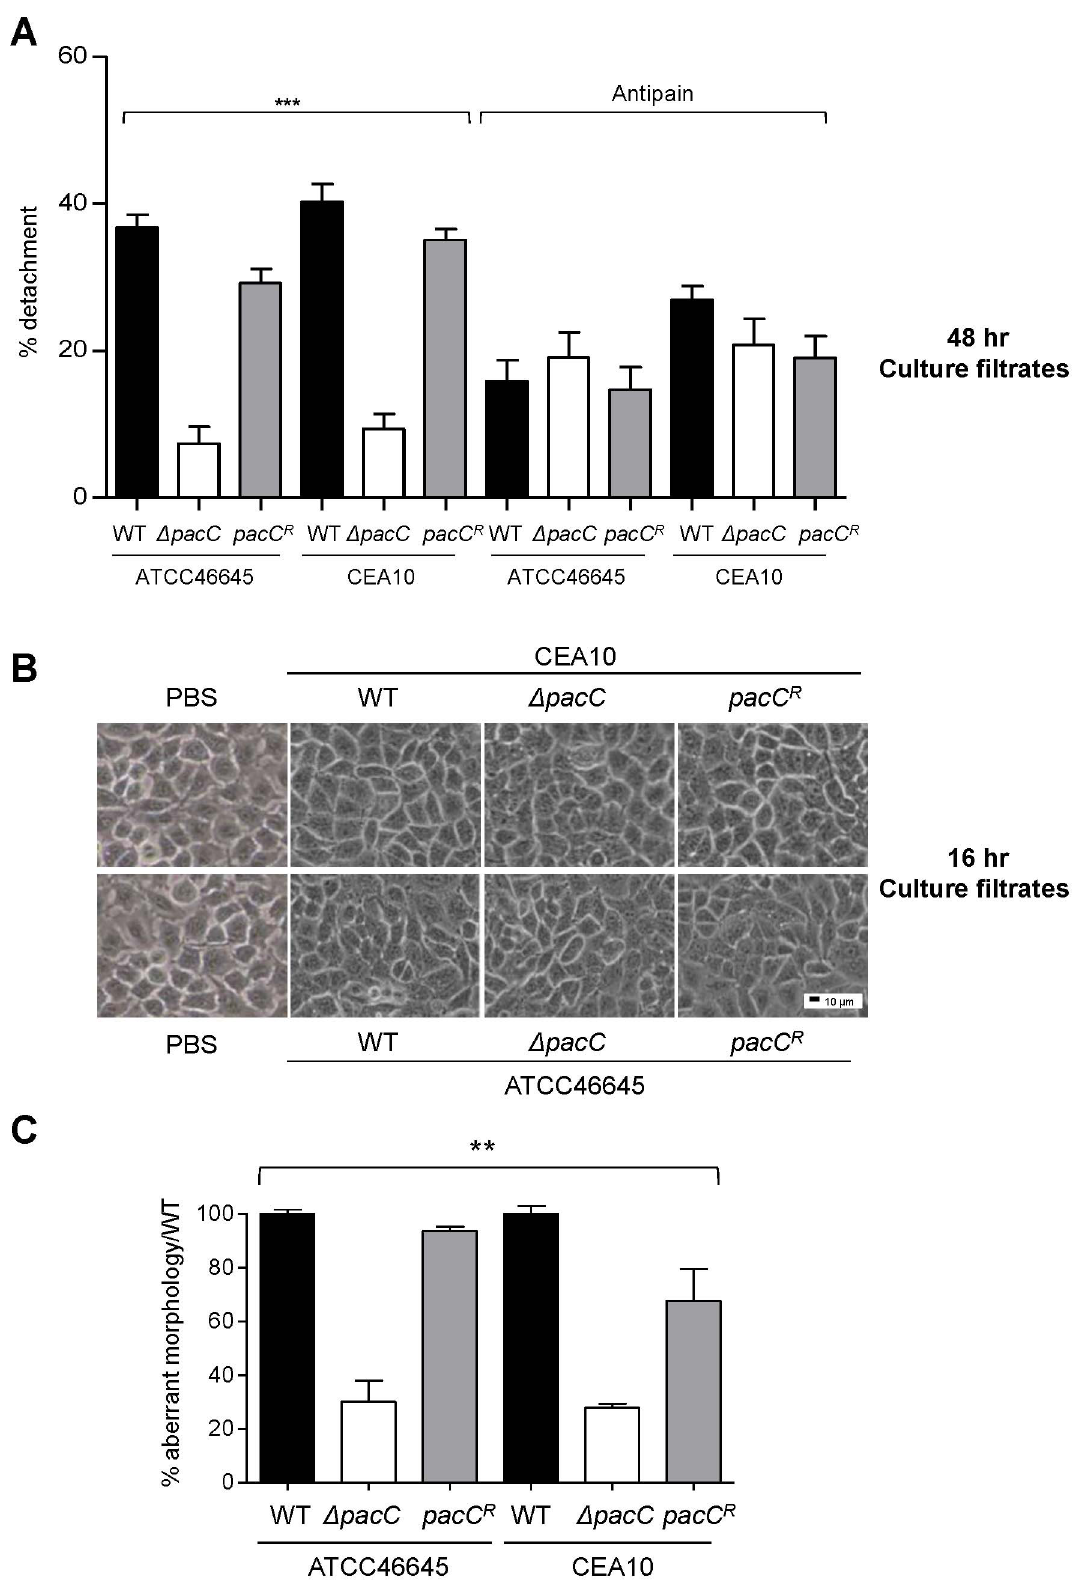
Figure 4. Distinct and sequential PacC-dependent activities elicit epithelial decay. (A) Percent detachment, relative to PBS challenge, of A549 cells exposed to antipain-treated and non-treated fungal culture supernatants (48 hr cultures, 10 5 spores/ml). (B) Integrity of A549 monolayers following exposure to fungal culture supernatants (16 hr cultures, 10 5 spores/ml). 200 6 magnification. (C) Percent aberrant morphology, amongst